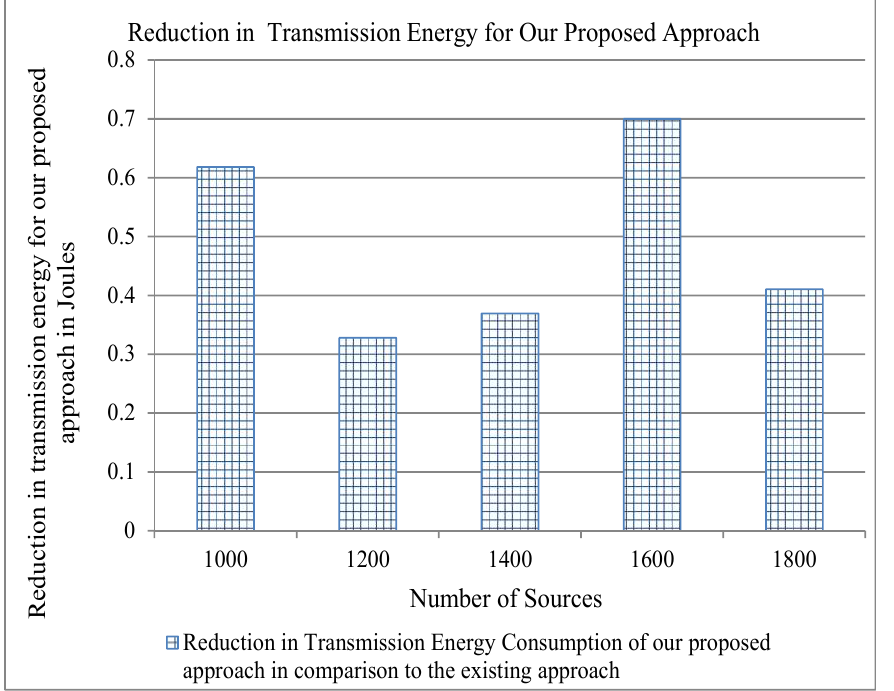
Figure 9. Reduction in Processing Energy for our proposed approach in comparison to the existing for two cache servers.